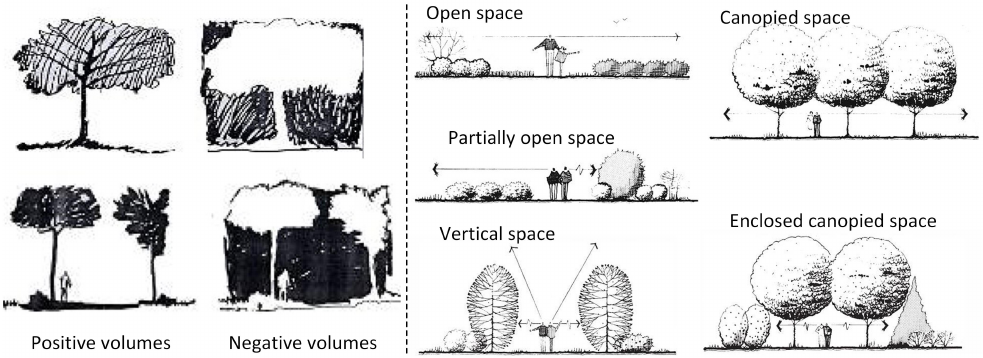
Figure 4. Space generation, classification and definition in landscape. The left figure indicates the cognition of landscape spaces from the view of space generation [44]; the right figure shows the spaces created by plant materials